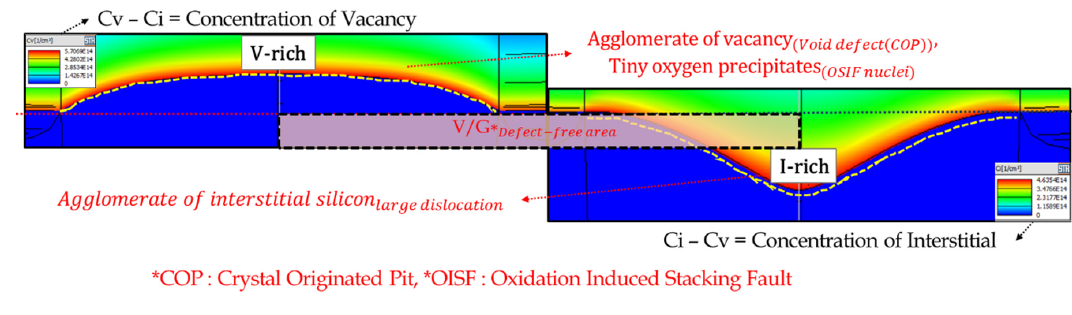
Figure 4. Area of free-defects from the vacancy, interstitial, COP, OISF and dislocation loops. Table 2. Analysis result of the crystal positions.